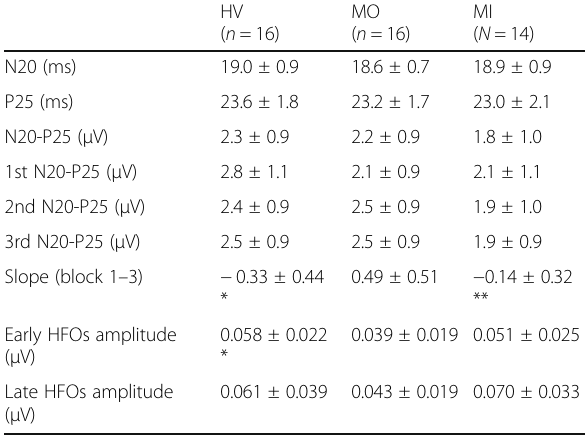
Table 2 Latencies and amplitudes of the various cortical SSEP components after median nerve stimulation (mean ± standard